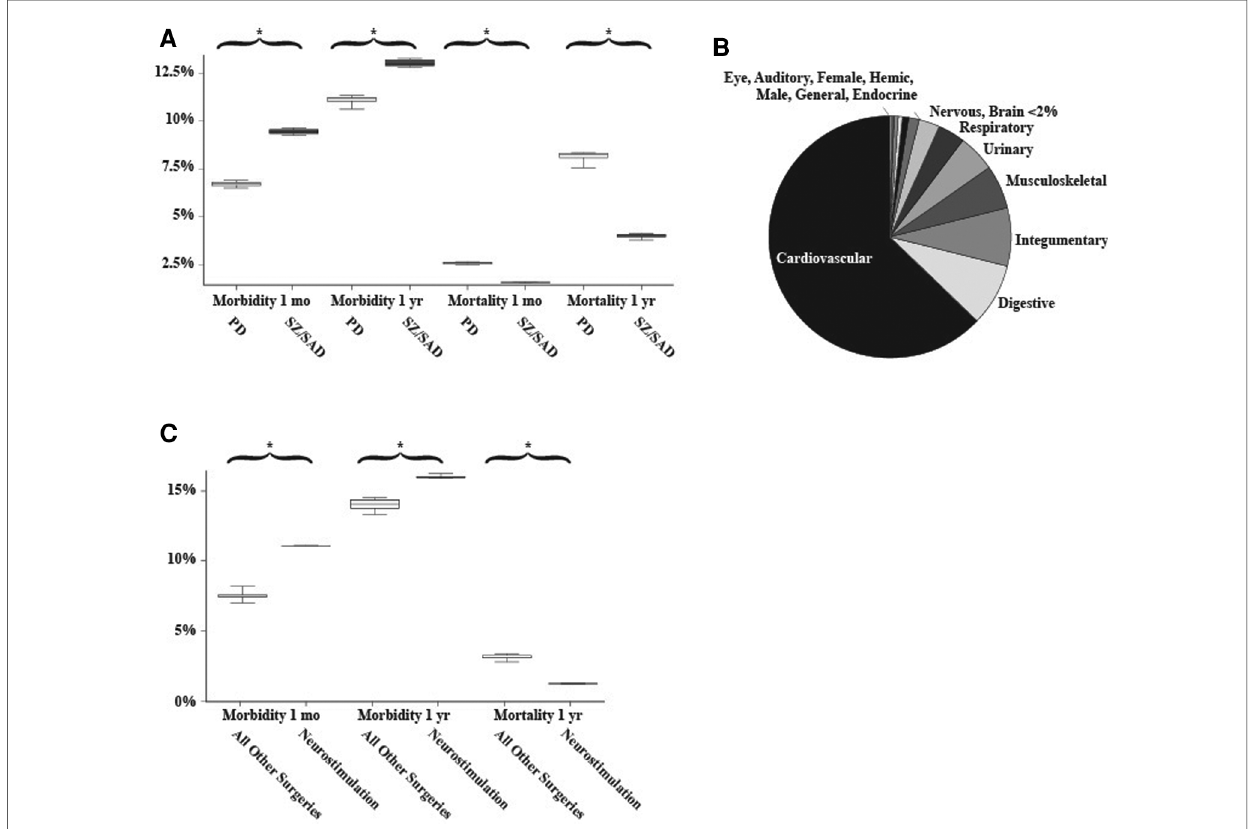
FIGURE 2 Matched analyses. ( A ) Frequencies of postsurgical morbidity and mortality between matched Parkinson ’ s disease and schizophrenia/schizoaffective disorder cohorts ( n =15,354 surgical cases/cohort). ( B ) The relative proportion of 14 of the common surgical procedures examined. Microscope, Maternity, Diaphragm, Intersex, and Reproductive surgeries made up <0.2% of the total. ( C ) Comparison of postsurgical morbidity and mortality between all surgeries (without neurostimulation/DBS) and only neurostimulation/DBS surgeries (grey). 1,389-4,787 surgical cases among those with Parkinson disease, essential tremor, dystonia, or epilepsy all older than 18 years of age. Whiskers indicate the range of 10 matched analyses, * indicates signi fi cant differences among paired